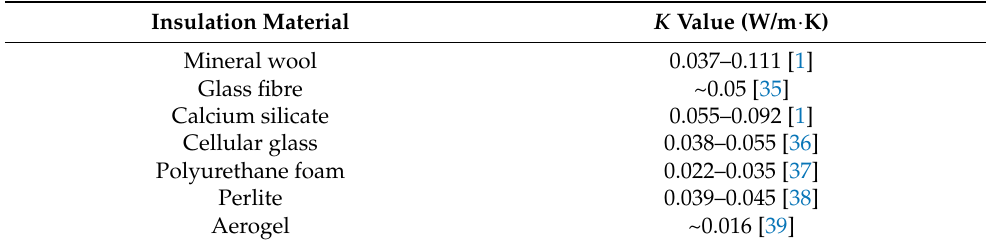
Table 1. K values of commonly used industrial thermal insulation